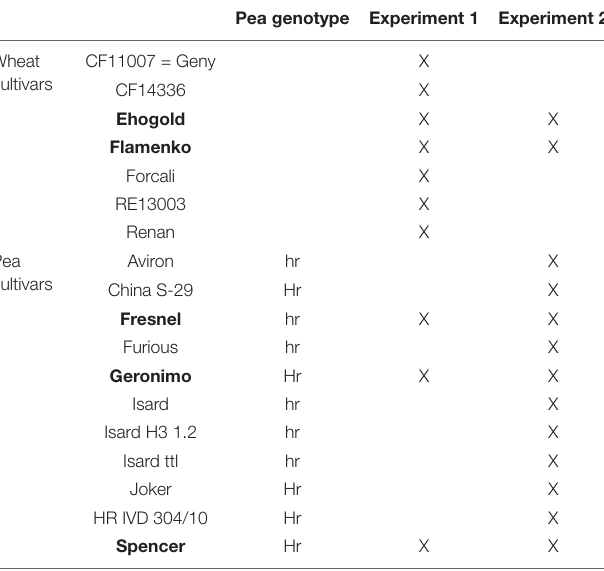
TABLE 2 | Wheat and pea cultivars used in the present